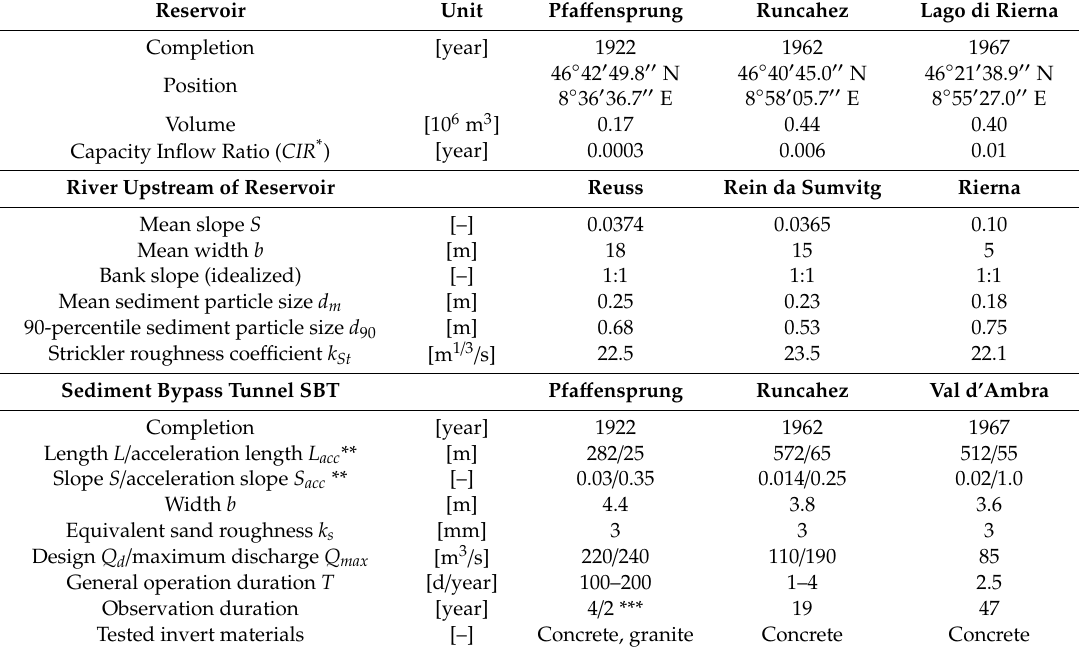
Table 1. Data of case study sediment bypass tunnels (SBTs) and respective reservoirs and rivers [48,50].